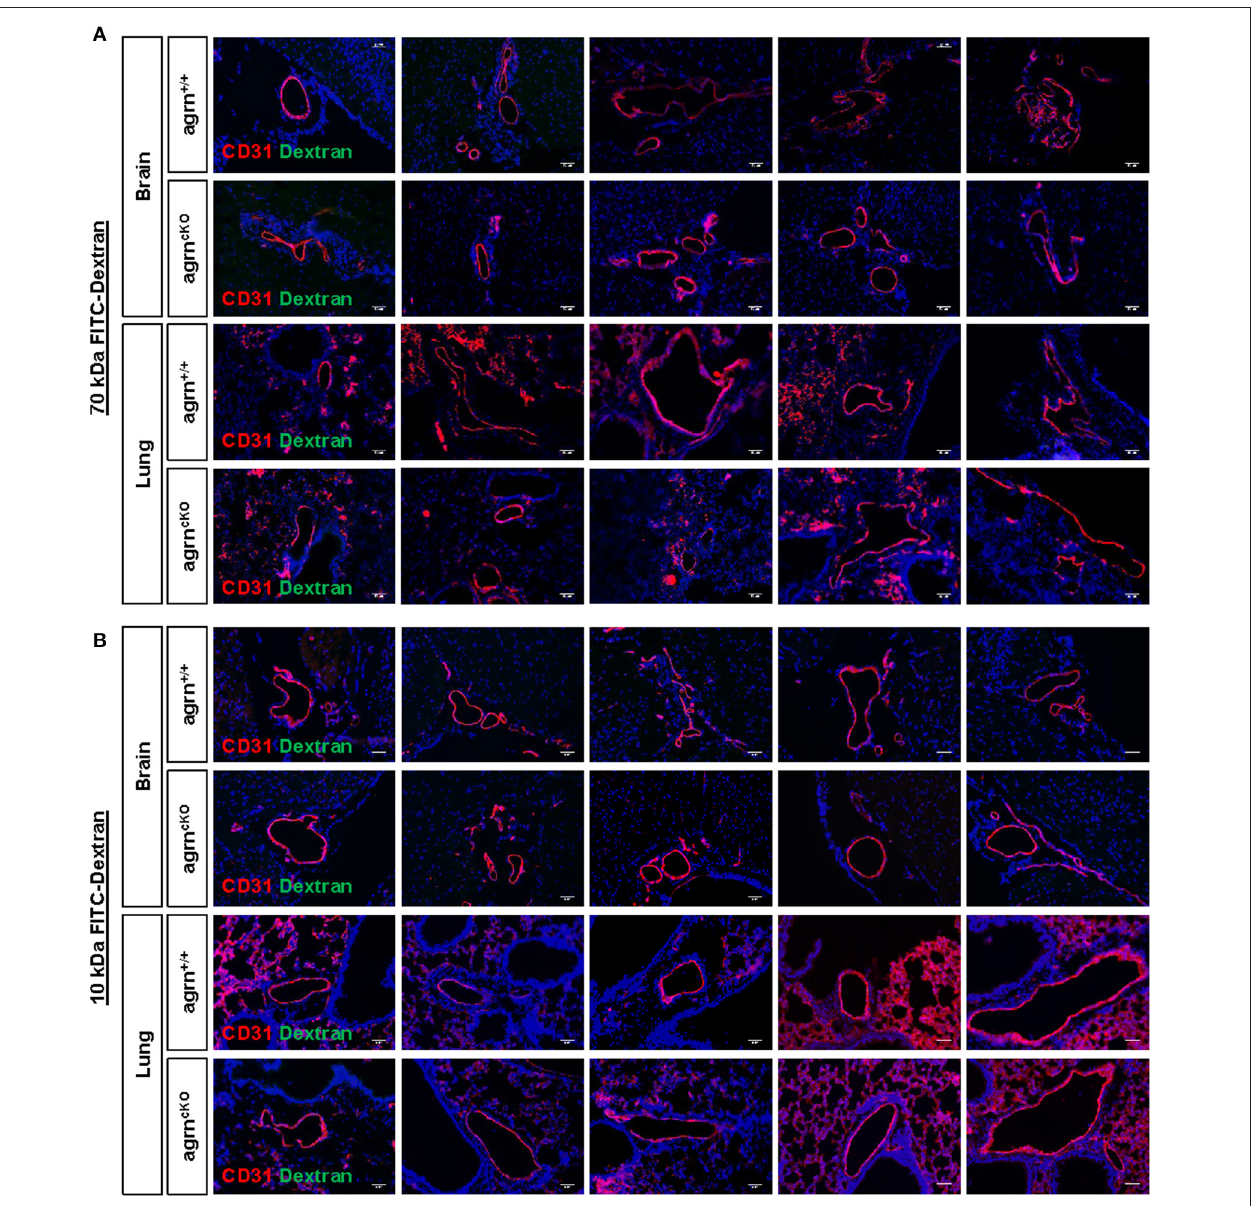
FIGURE 2 | Endothelial agrin is dispensable for the maintenance of vascular barrier integrity in vivo . The in vivo vascular permeability was examined at 30min after intravenous injection of (A) 70 and (B) 10 kDa FITC conjugated Dextran into the tail veins of 6–8 weeks old EC-agrn + / + and EC-agrn cKO mice, respectively. Immunostaining on brain and lung frozen sections for CD31 (red), dextran (green) and nuclear counterstain by DAPI (blue) respectively showing no significant difference in vascular barrier integrity in vivo after endothelial loss of agrin, scale bars: 50 um.